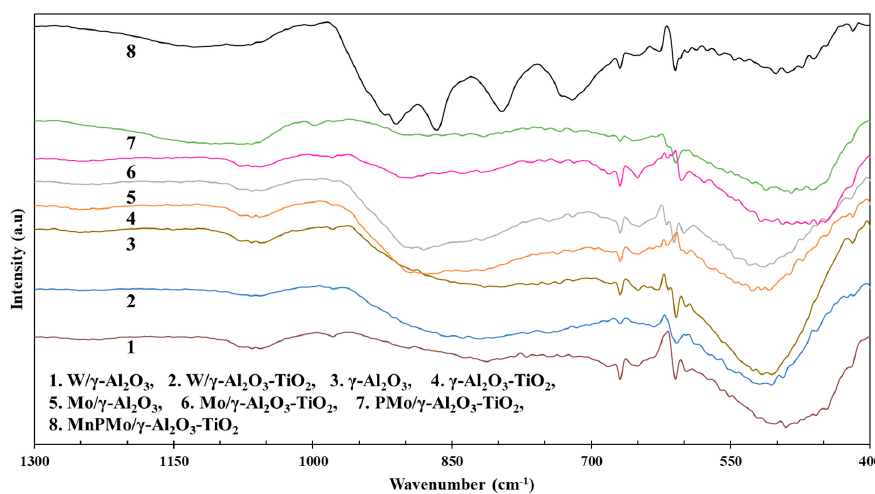
Figure 4. Fourier transform-infrared (FT-IR) spectra of supported catalysts.